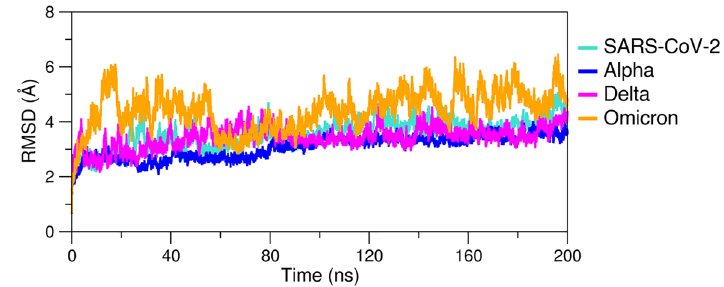
Figure 1. RMSD for RBD WT –ACE2, RBD Alpha –ACE2, RBD Omicron –ACE2 and RBD Delta –ACE2